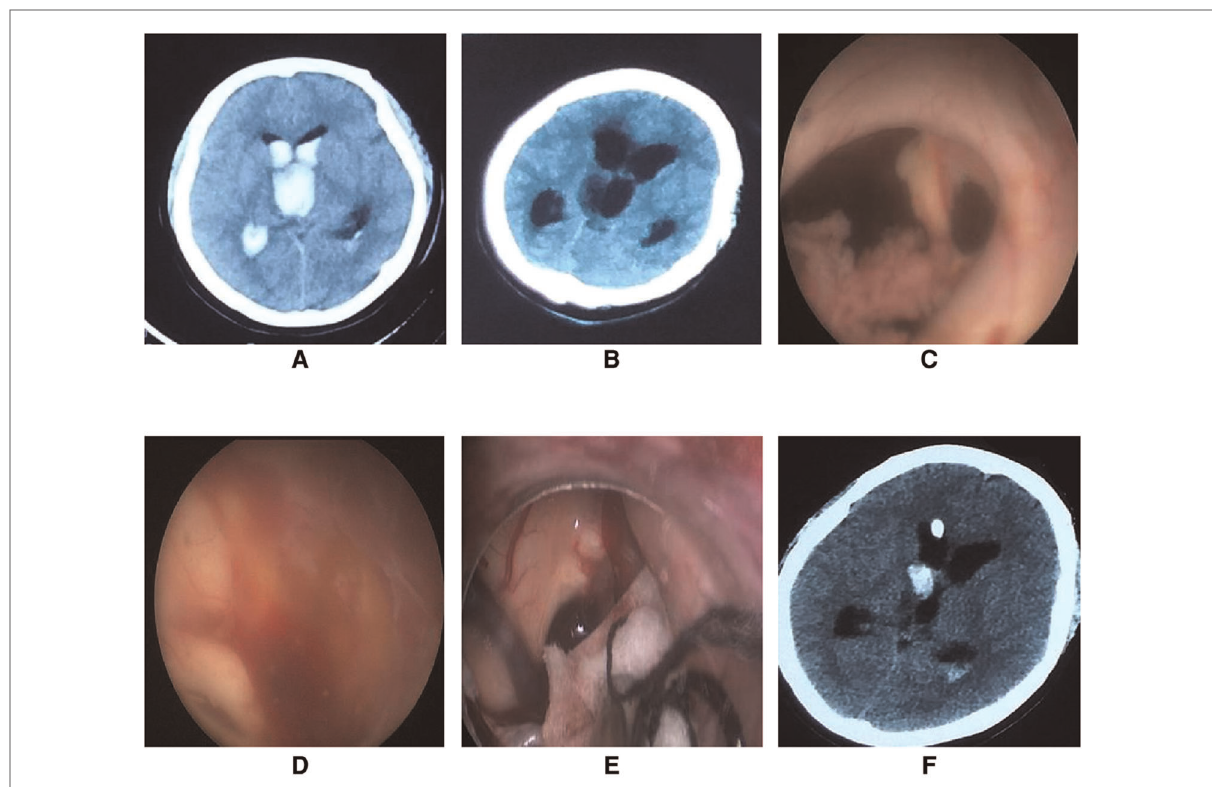
FIGURE 5 Endoscopic intraventricular surgery was performed to perform ETV in case 14. ( A ) On admission, CT scans revealed a ventricular hemorrhage with hydrocephalus. ( B ) CT scan of hydrocephalus on the third day after extubation of the drainage catheter. ( C ) Connective tissue was found in the foramen of Monro during surgery. ( D ) The third ventricle was full of red-yellow hemosiderin and the bottom of the third ventricle was unrecognizable. ( E ) A patty and slim bipolar was used to stop the bleeding through the extra-endoscopic technique. The source of bleeding was located in the choroid plexus of the lateral ventricle near the foramen of Monro. ( F ) CT scans on the fi rst day after endoscopic surgery showed a small hemorrhage in the right lateral